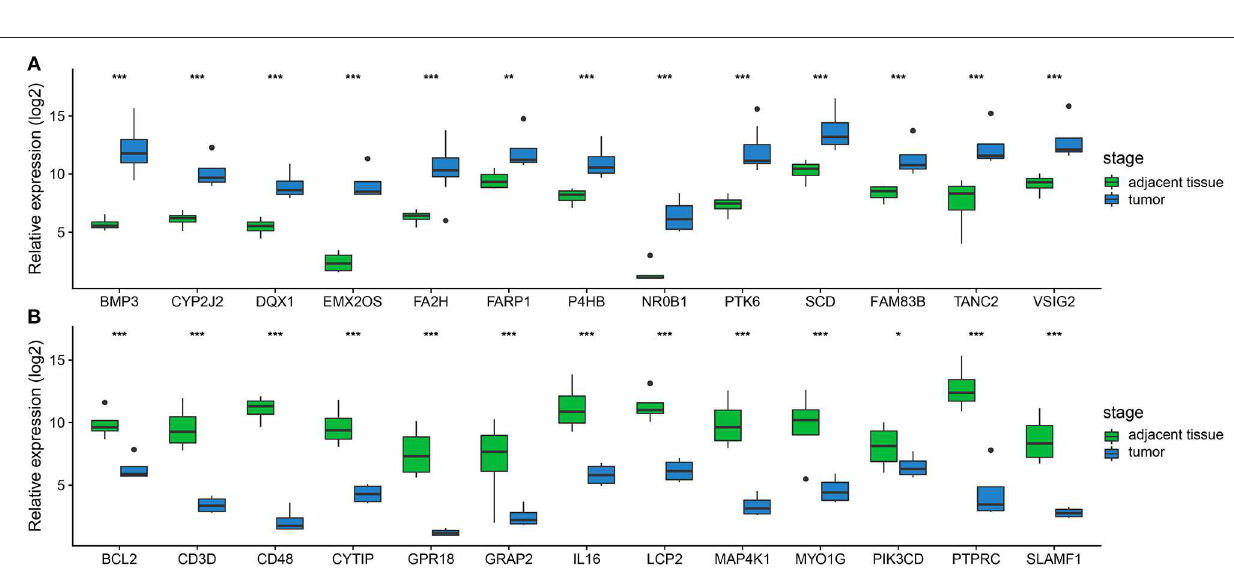
Frontiers in Oncology | www.frontiersin.org